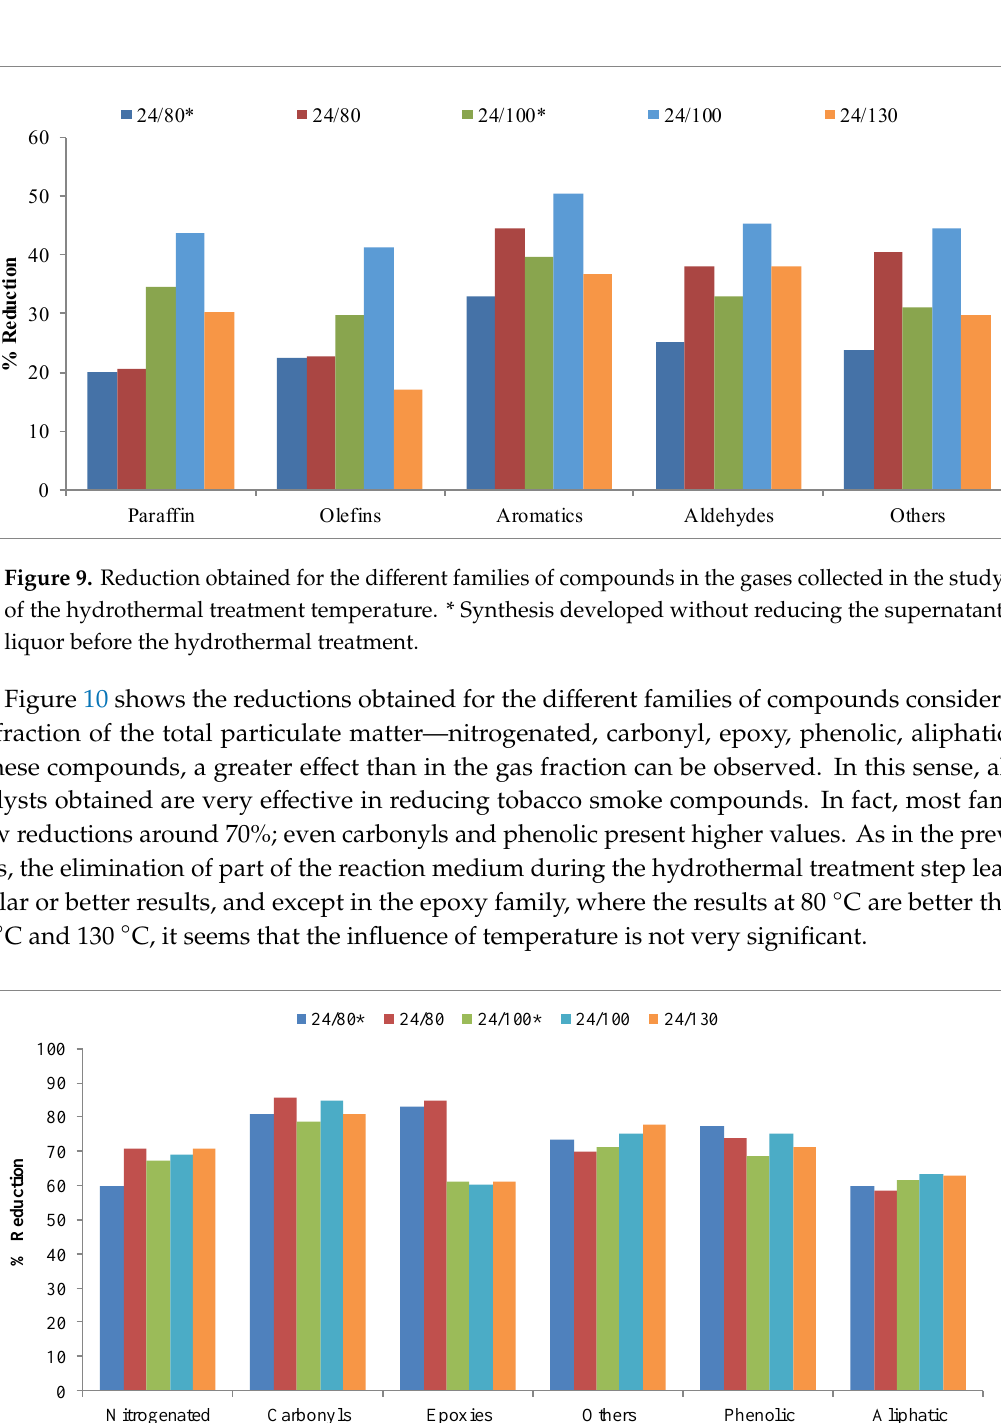
Figure 10. Reduction obtained for the different families of compounds in the total particular matter collected in the study of the hydrothermal treatment temperature. * Synthesis developed without reducing the supernatant liquor before the hydrothermal